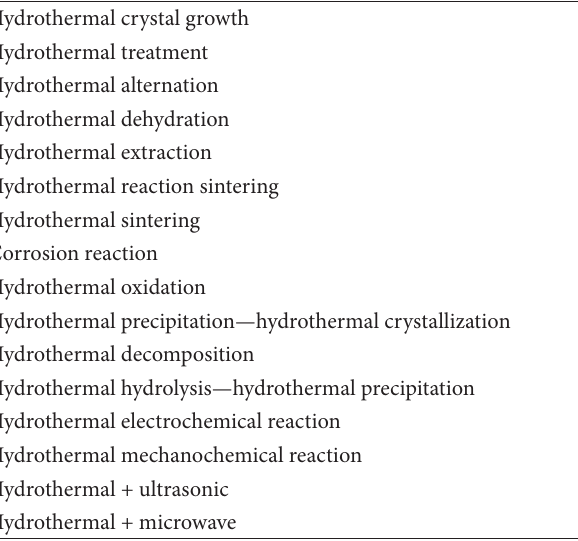
Table 4: Hydrothermal